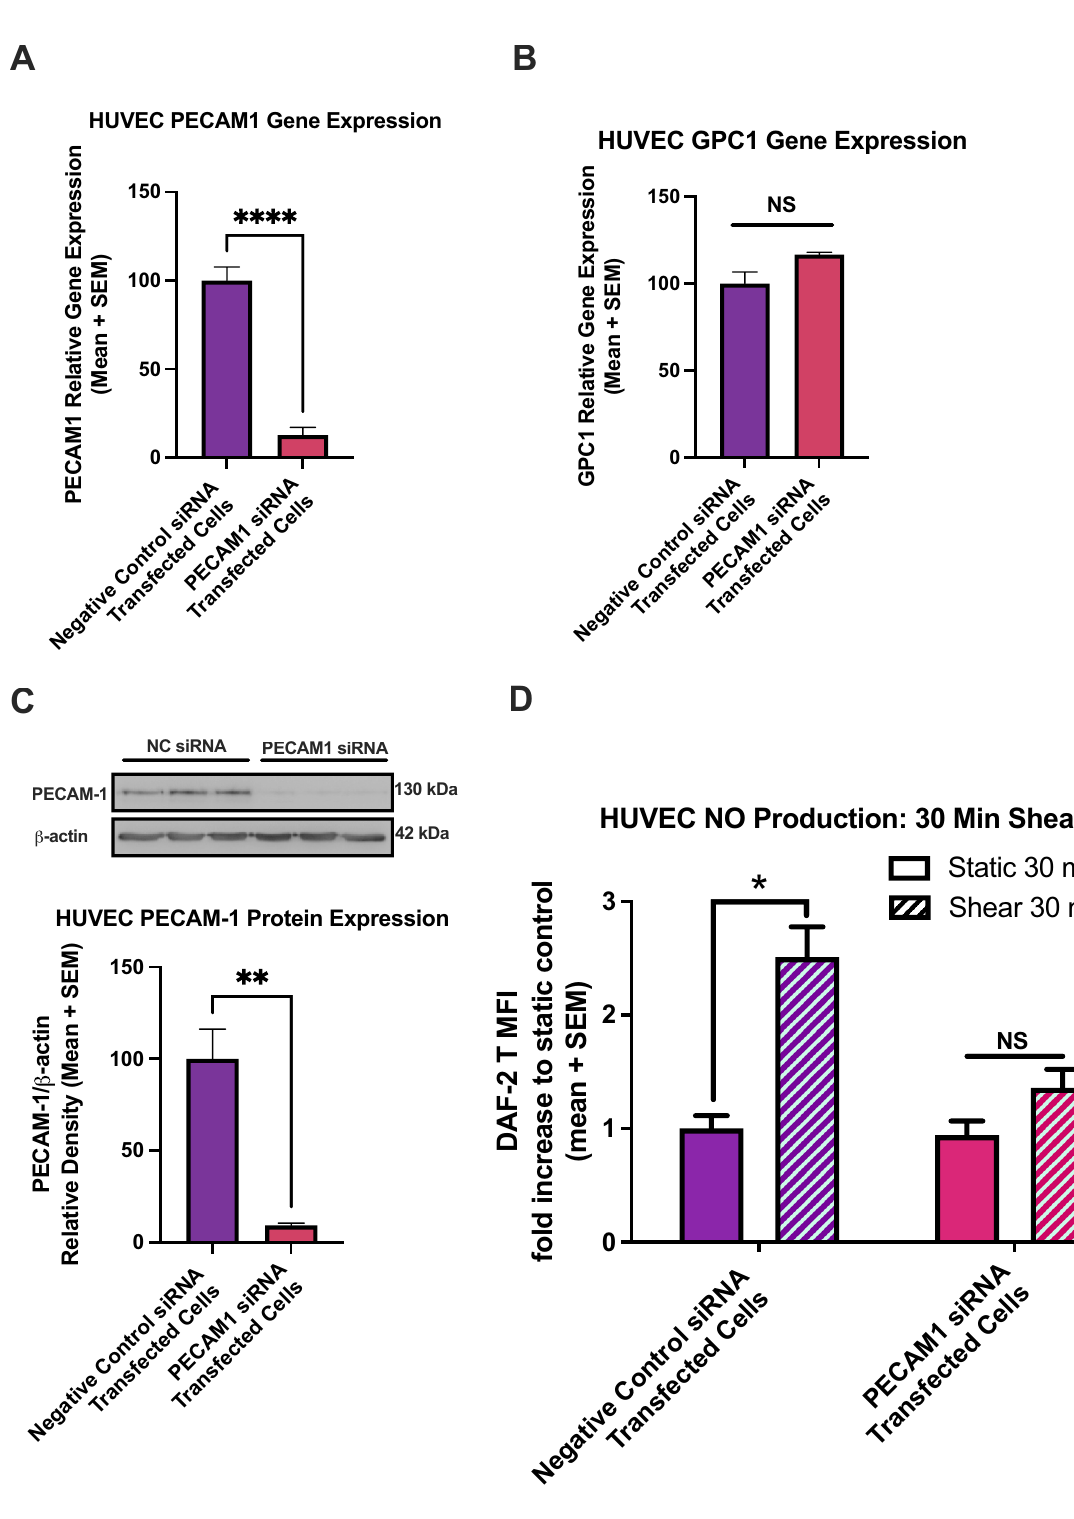
Figure 3. PECAM-1 knockdown blocks shear-induced NO production at 30 min in HUVEC. ( A ) PECAM1 gene expression is shown in cells transfected with negative control siRNA and with siRNA specific to PECAM1 mRNA (n = 10 for each group). Gene expression was normalized to GAPDH and β-ACTIN expression levels and both transfection groups were normalized to the negative control expression data, set to 100% expression. *P < 0.05 using two-tailed student’s t-test. ( B ) GPC1 gene expression is shown in transfected cells (n = 4 for each group). Expression levels did not significantly change using two-tailed student’s t-test. ( C ) PECAM-1 protein expression in transfected cells (n = 3 for each group) and corresponding western blot. *P < 0.05 using two- tailed student’s t-test. Full length blot is presented in Supplemental Figure S8. ( D ) DAF-2T normalized levels are shown for transfected HUVEC exposed to 30 min of fluid shear stress. From left to right, n = 8, 16, 8, 16. *P < 0.05 using one-way ANOVA followed by Sidak’s multiple comparisons